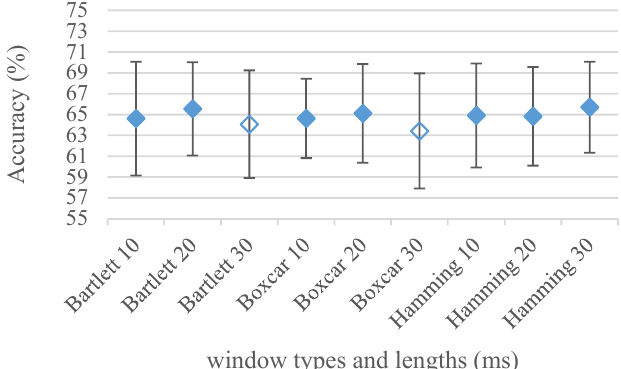
Figure 5. Averaged accuracies and standard deviations for Bartlett, Boxcar, and Hamming windows, in case of 10, 20, and 30 ms frame lengths, and 4 kHz maximal frequency. Filled marks show equally performing settings.